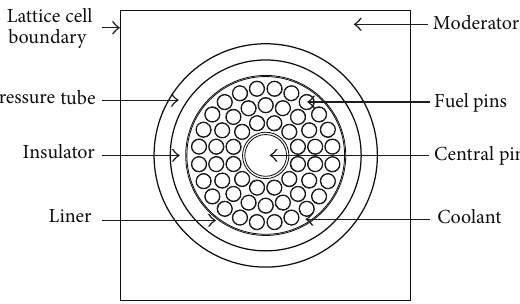
Figure 3: Canadian SCWR 54 elements fuel bundle and high efficiency fuel